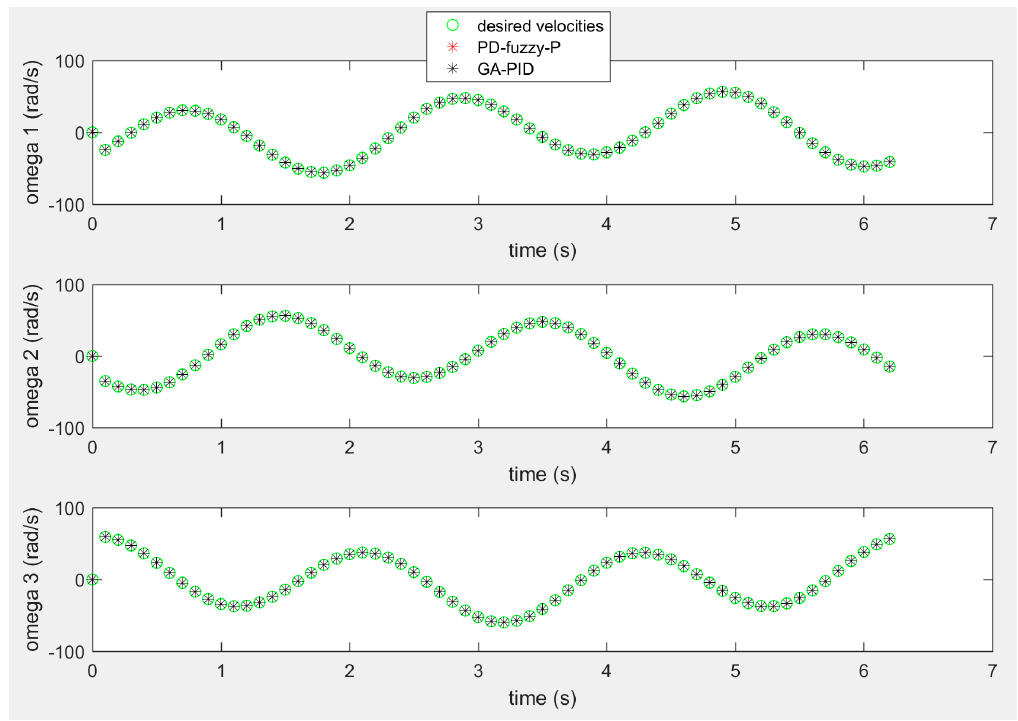
Figure 12. The angular velocities of the omnidirectional robot’s wheels of the rose shaped path.